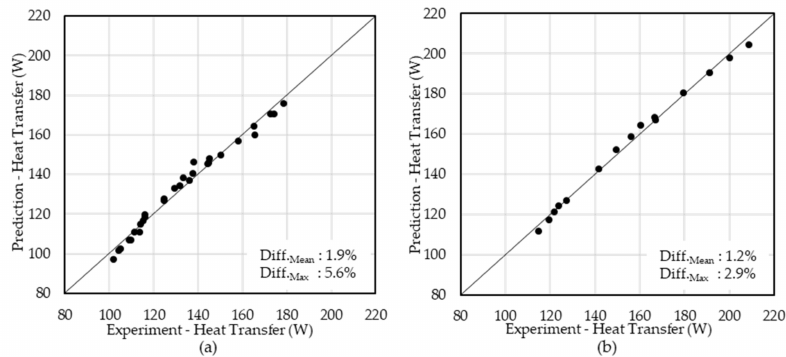
Figure 9. Di ff erence comparison of experimental and numerical results of heat transfer of the plate-fin heat exchanger ( a ) plain; ( b ) o ff set fin.